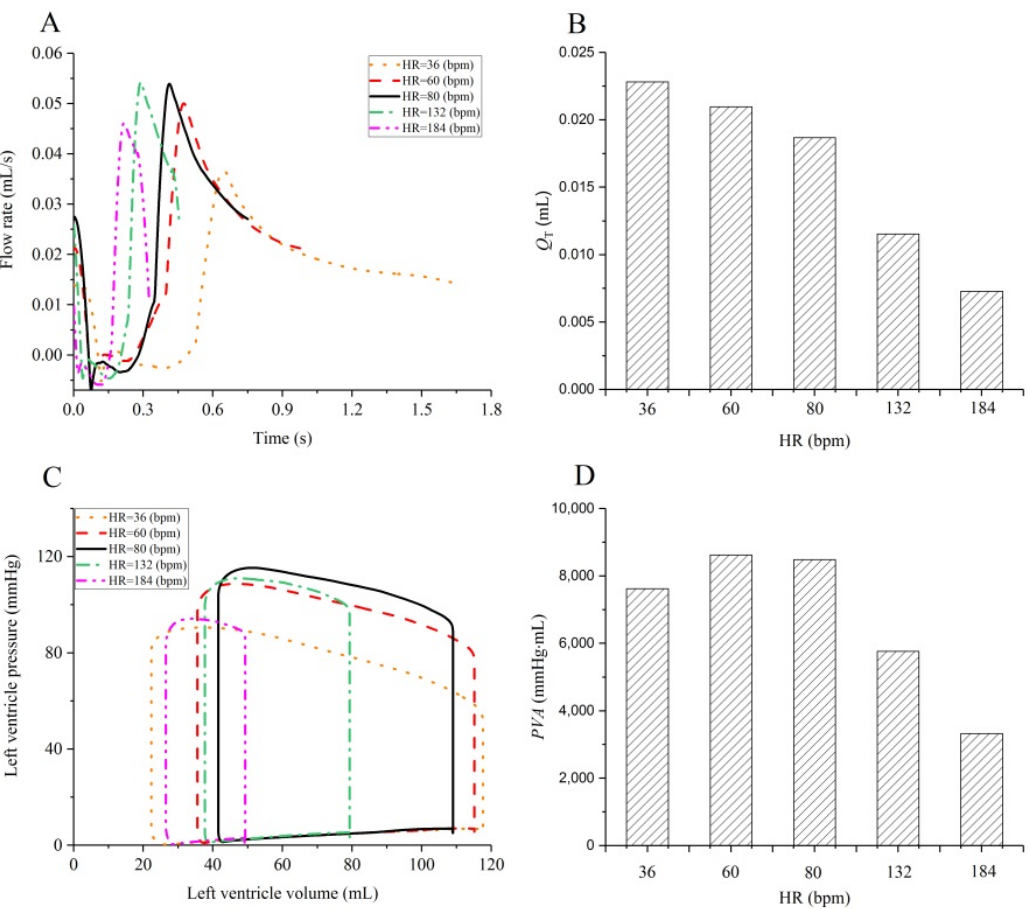
Figure 3. Model-simulated blood flow waveforms ( A ) and amount of blood flow ( Q T ) ( B ) in LAD b1 ; and pressure-volume loops ( C ) and pressure-volume areas ( PVA ) ( D ) of the left ventricle under different HR conditions.